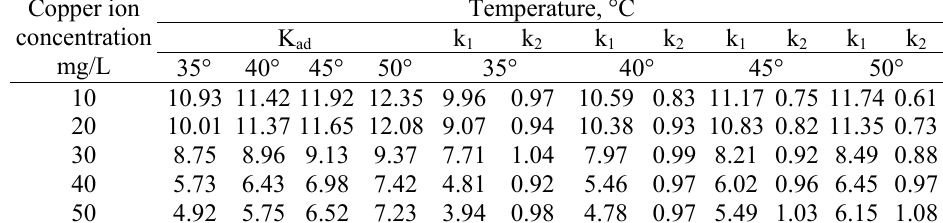
Table 8. Intra particle diffusion (K ) for the adsorption of copper ion by CBC p Copper ion concentration, mg/L